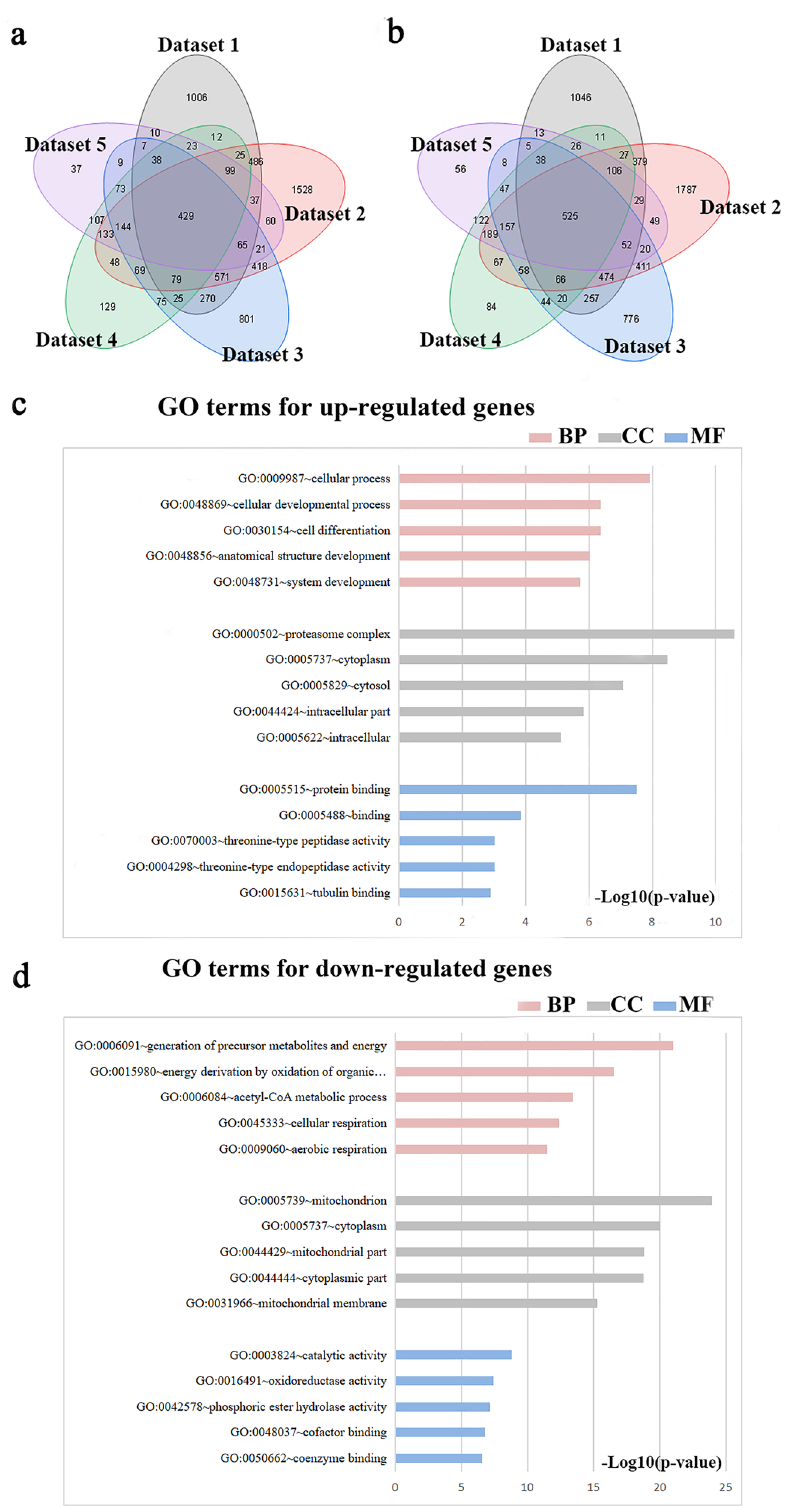
Figure 2. DEGs and GO terms in denervated muscle atrophy were identified. Venn diagrams for ( a ) up-regulated mRNAs and ( b ) down-regulated mRNAs were drawn based on 5 denervated muscle atrophy datasets. GO analysis of DEGs in denervated muscle atrophy were conducted for ( c ) up- and ( d ) down-regulated mRNAs respectively (Each figure shows the top10 terms with the lowest p value). BP biological process, CC cellular component, MF molecular